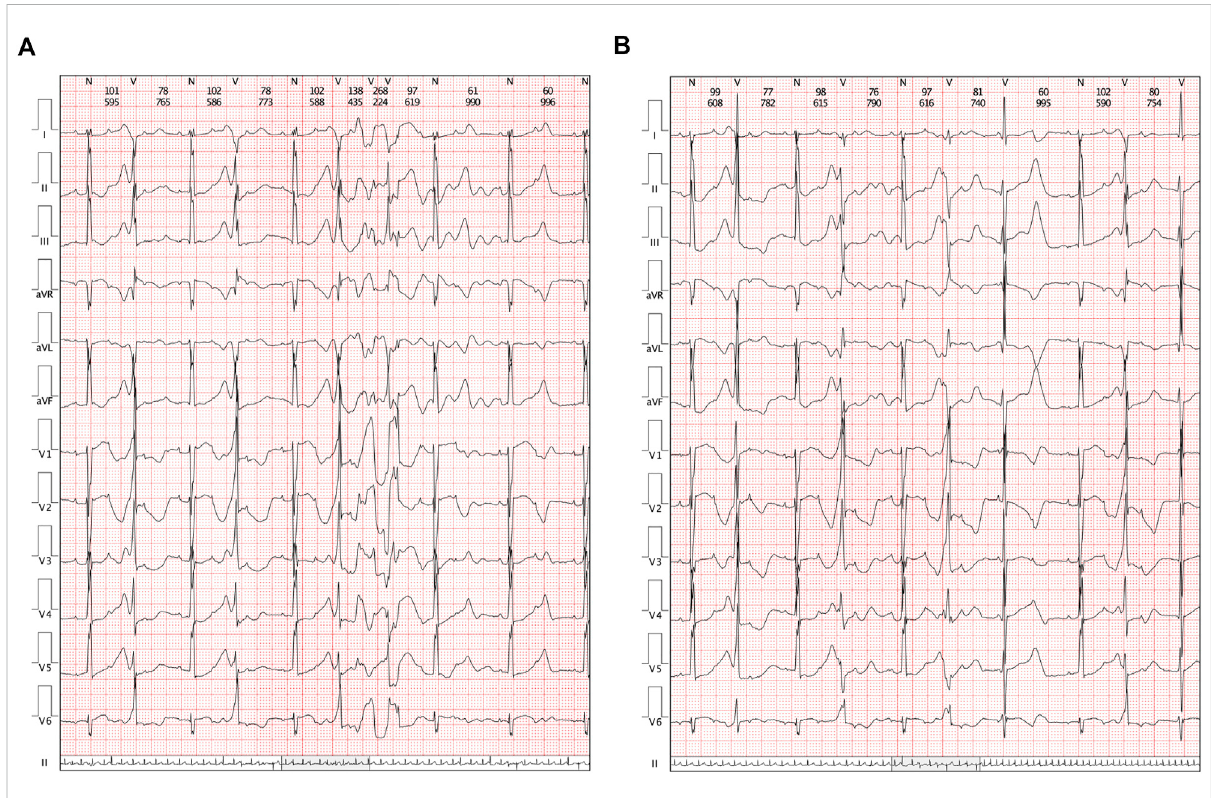
FIGURE 2 Clinical manifestations in Holters. (A) Transit ventricular tachycardia was identi fi ed. (B) Holter demonstrated a paired premature ventricular